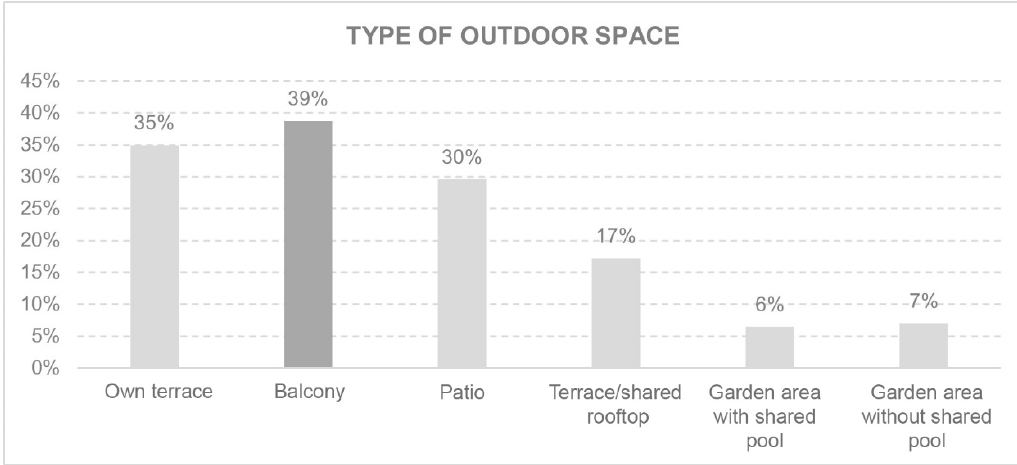
Figure 10. Type of outdoor space.